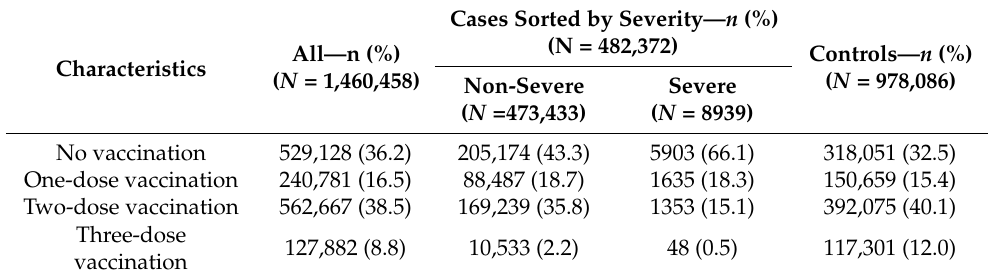
Table 2. Vaccination status of cases and controls included in the conditional logistic